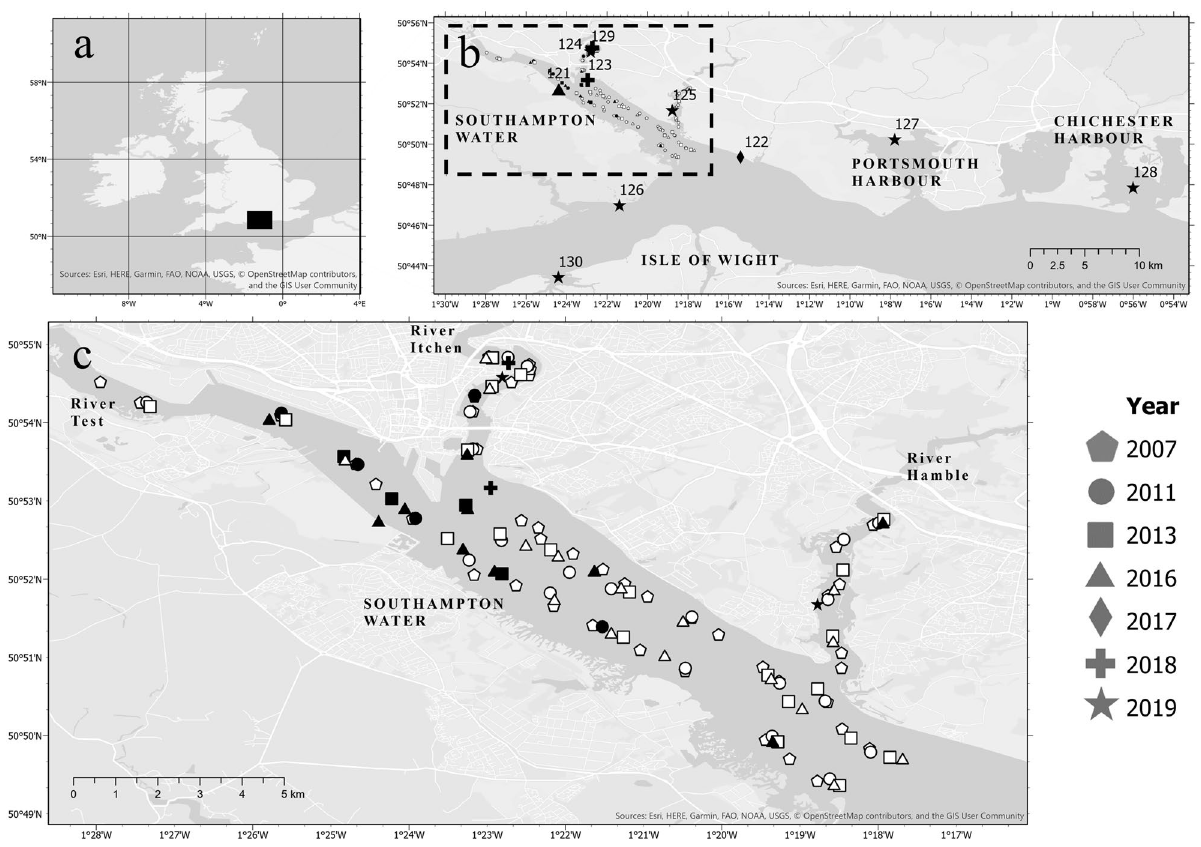
Figure 1. ( a ) Map of the UK denoting the Solent survey region. ( b ) Locations across the Solent region where A. senhousia has been detected. ( c ) Distribution of A. senhousia in the Solent focusing on Southampton Water and its tributaries as determined by EA benthic surveys. Dashed rectangle in ( b ) denotes area ( c ). Black fill indicates presence of A. senhousia , white fill indicates absence. Overlapping symbols are layered in order of year (most recent at the top). Symbols without numbers are Environment Agency (EA) survey sites (site numbers excluded to maximise clarity of map); EA site locations and associated A. senhousia densities can be found in Supplementary Table S2. Numbers 121–130 refer to surveys by other organisations (see Table 1). Mean densities for all surveys can be seen in Table 1. Site 128 is not a specific location but represents one